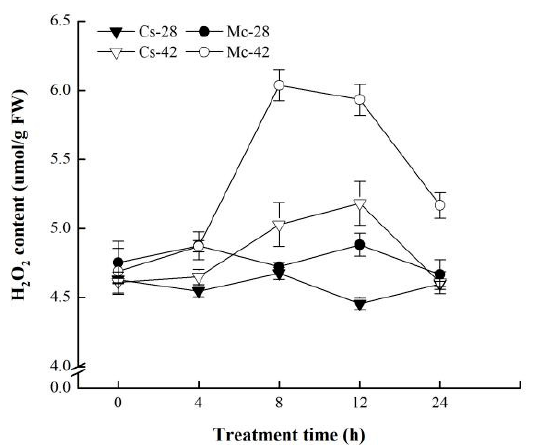
Figure 4. Interactive effects of bitter melon rootstock and grafted cucumber seedlings on the time course change of the H 2 O 2 content in grafted cucumber leaves under heat stress conditions. Self-grafted plants exposed to 28 ℃ /18 ℃ (day/night), Cs-28; bitter-melon-grafted plants exposed to 28 ℃ /18 ℃ (day/night), Mc-28; self-grafted plants exposed to 42 ℃ /32 ℃ (day/night), Cs-42; bitter-melon-grafted plants exposed to 42 ℃ /32 ℃ (day/night), Mc-42. The values are the means ± SE of three independent experiments. The bars represent the standard error.